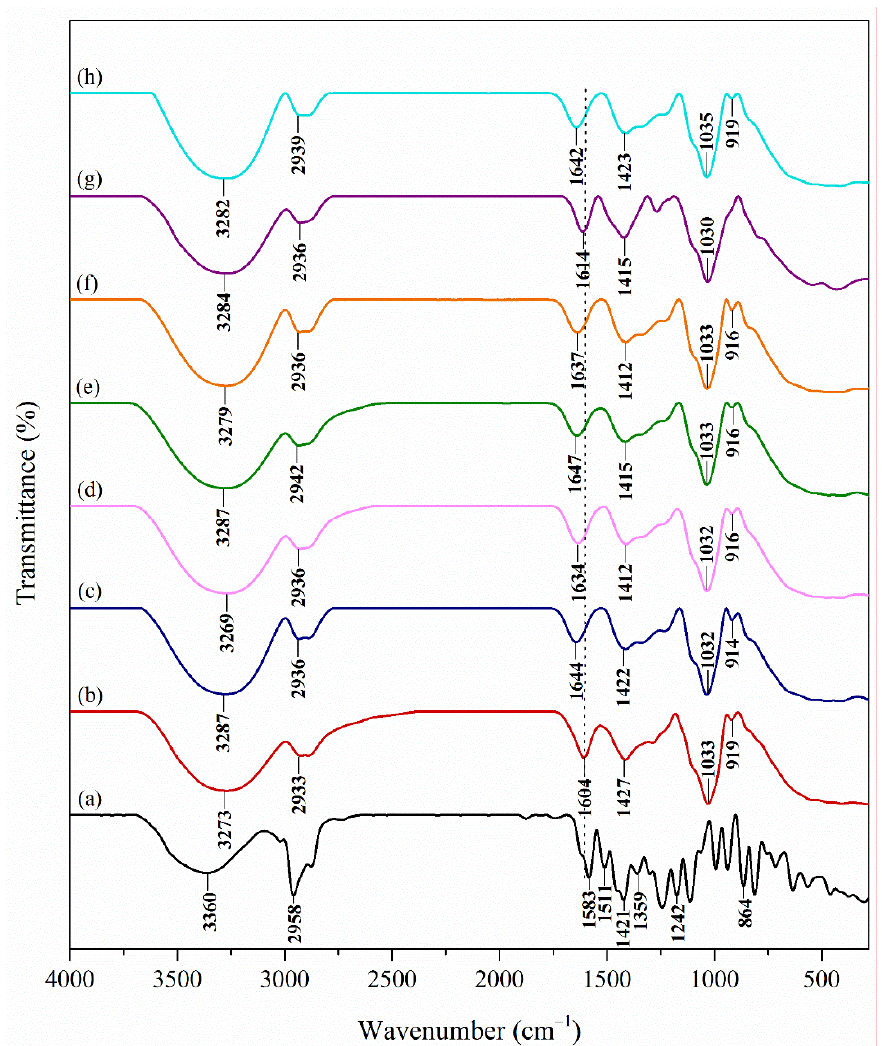
Figure 1. FTIR spectra of ( a ) carvacrol, ( b ) pure GG, ( c ) GG-Carv 01, ( d ) GG-Carv 02, ( e ) GG-Carv 04, ( f ) GG-Carv 08, ( g ) GG-Carv 16 and ( h ) GG-Carv 32.